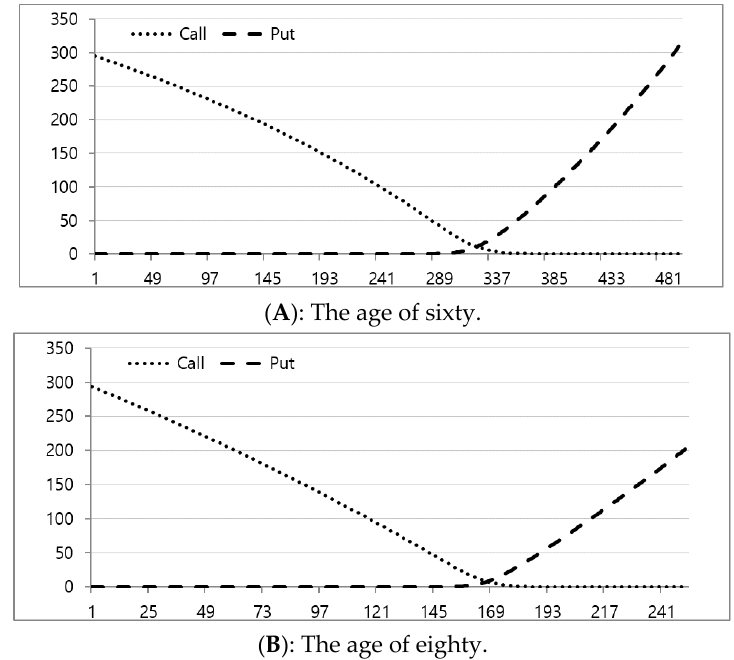
Figure 6. Maturity sensitivity analysis. This figure exhibits the estimated total option value by age